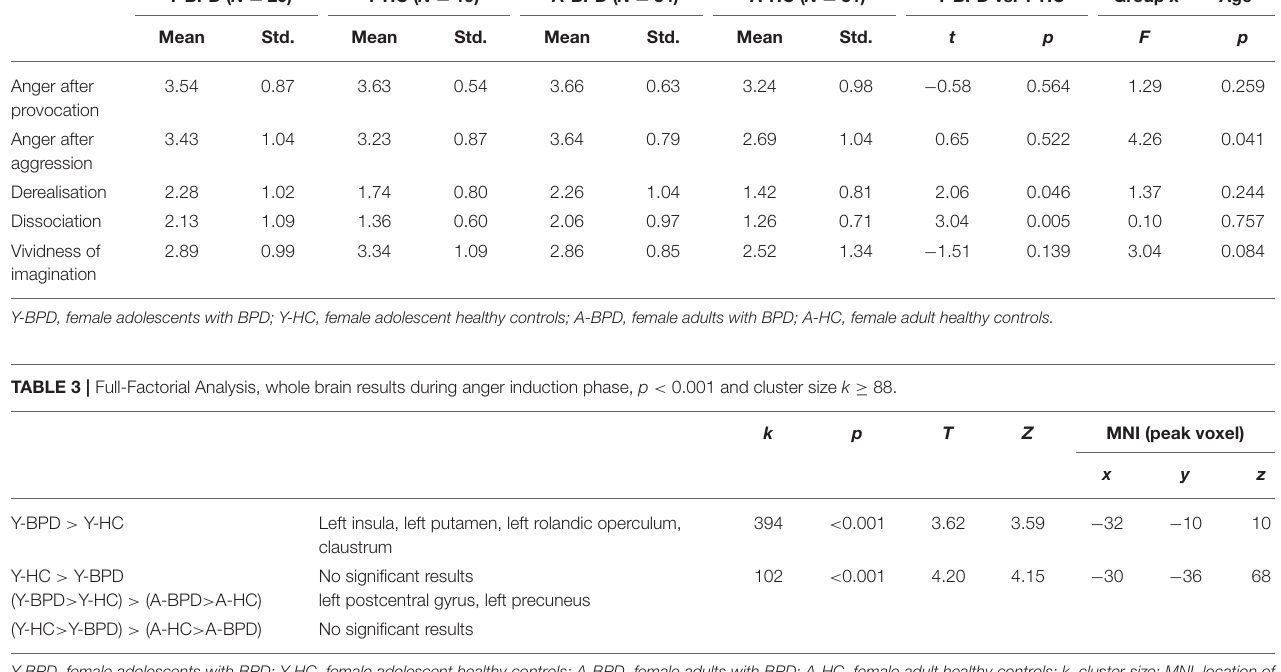
TABLE 2 | Self-rating data. Y-BPD ( N = 20) Y-HC ( N = 19) A-BPD ( N = 34) A-HC ( N = 31) Y-BPD vs. Y-HC Group x Age Mean Std. Mean Std. Mean Std. Mean Std. t p F p